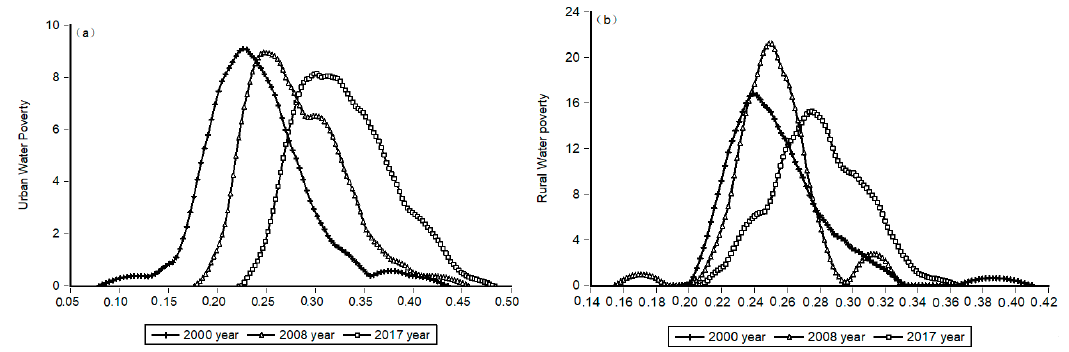
Figure 4. The kernel density distribution map of urban ( a ) and rural ( b ) water poverty in northwest China.